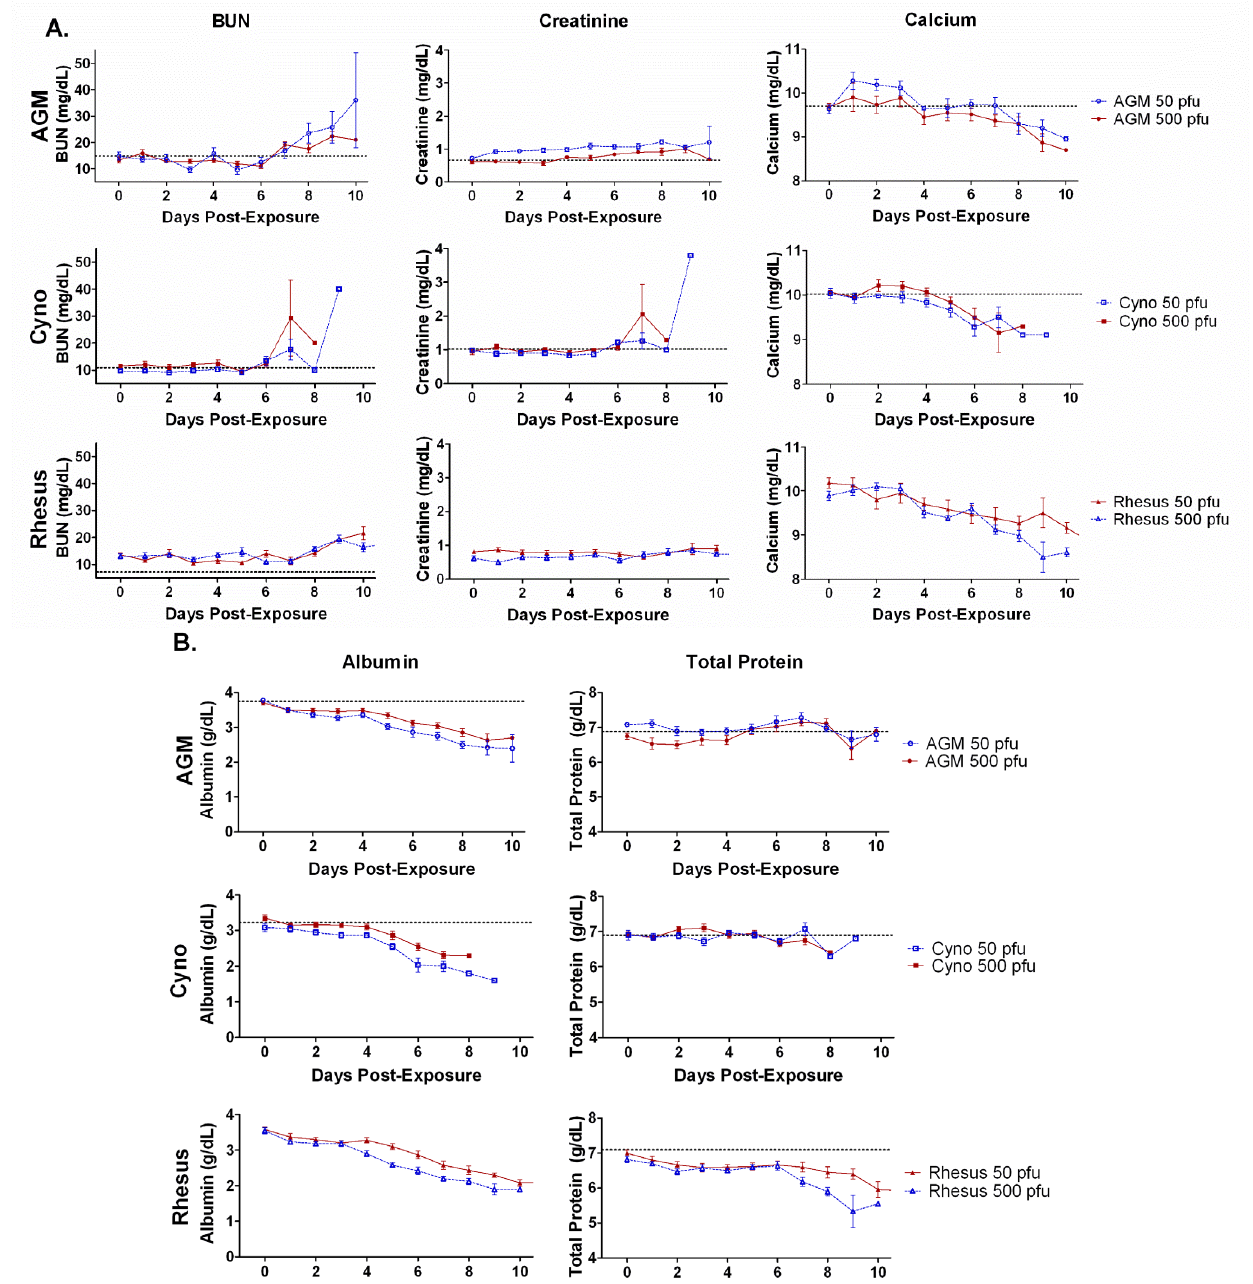
Figure 4. Blood urea nitrogen (BUN), creatinine, total calcium, albumin, and total protein averages. Graphs are shown for the group averages of A ) BUN, creatinine, and total calcium, and B ) albumin and total protein in three NHP species after exposure to two different doses of aerosolized SUDV. Average measurements on day 0 were taken before exposure serve as a baseline. There were six animals per group. Error bars represent the standard error of the mean. The horizontal dashed line indicates the average baseline (day 0) for the 12 animals in both dosage groups. BUN increases were significant for African green monkeys (AGM), rhesus 50 pfu, and cyno 50 pfu groups ( p <0.05). Creatine increases were significant for AGM groups and rhesus 50 pfu groups ( p <0.001). Calcium decreases were significant for all groups ( p <0.01) except the AGM 50 pfu group. Albumin decreases were significant for all groups ( p <0.01). Decreases in protein were significant for all groups ( p ≤0.01) except for AGM 500 pfu and cyno 50 pfu